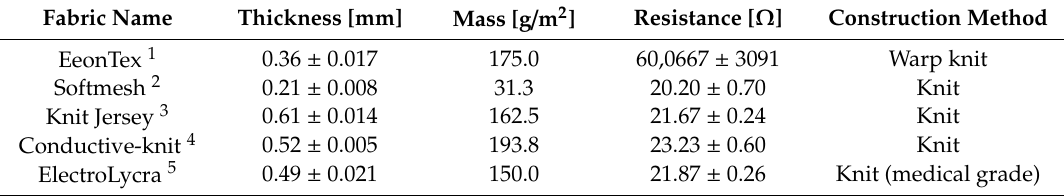
Table 1. Mechanical and electrical properties of the five di ff erent conductive and stretchable